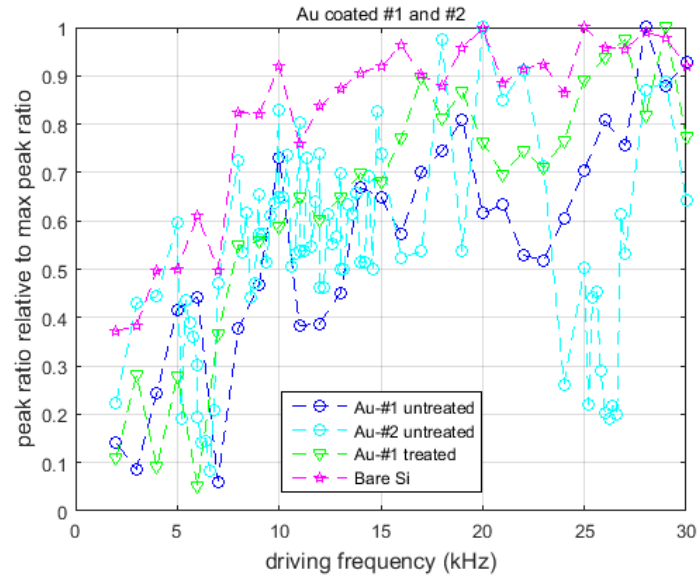
Figure 10. Valley frequency shift observed in the Ti-Au untreated specimen.